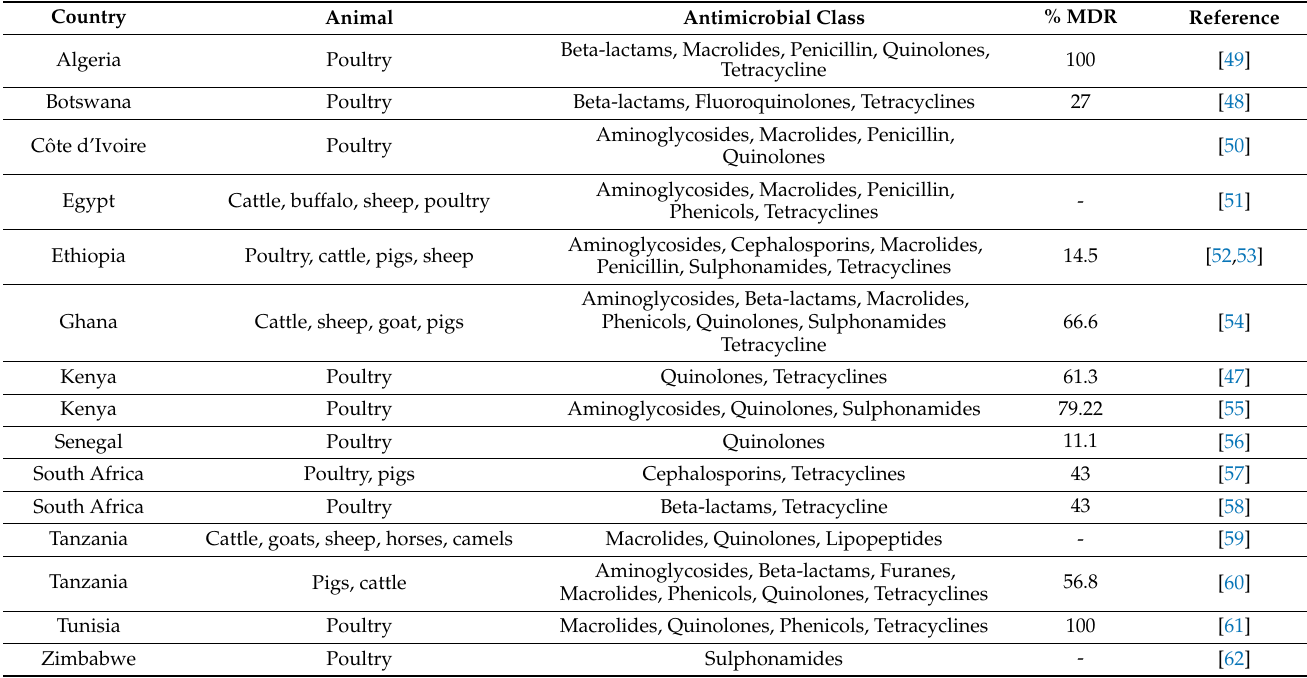
Table 1. Antimicrobial resistance in Campylobacter species by animal species and